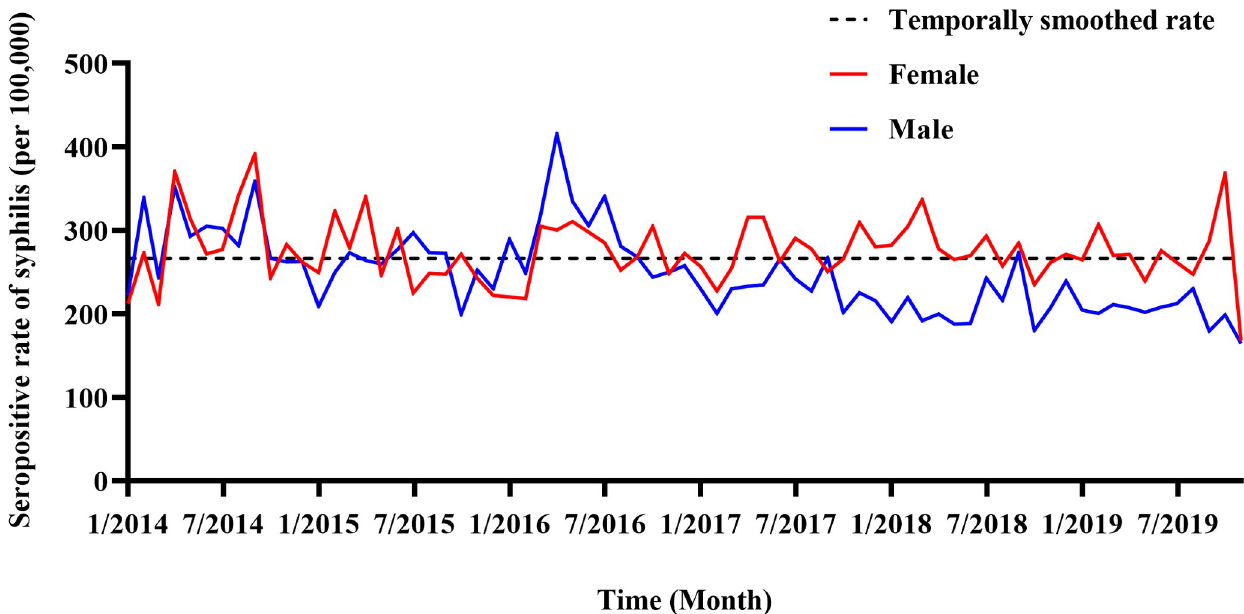
Fig 2. Preconception syphilis seroprevalence among married individuals aged 21–49 years enrolled in the National Free Preconception Health Examination Project in Guangdong Province, 2014–2019. We computed temporally smoothed rates as the sum of all seropositive cases divided by the sum of participants across the years, and then multiplied by 100,000.